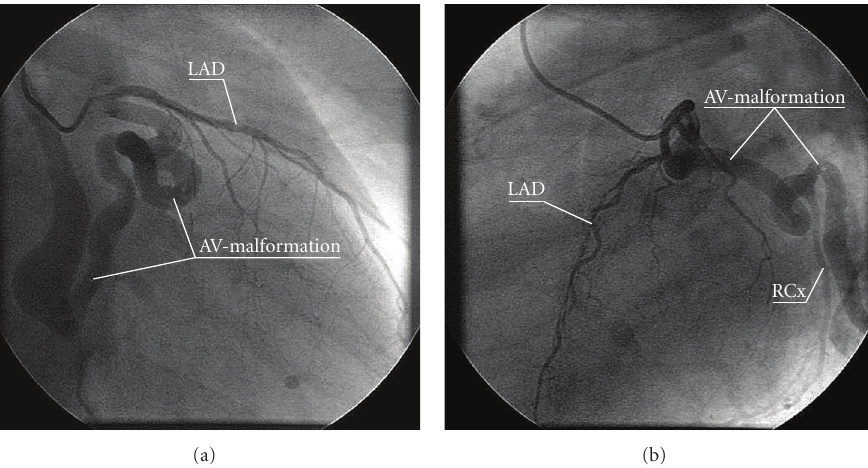
Figure 1: (a) Coronary arteriography showing a large and tortuous arteriovenous malformation originating from the left coronary sinus with a massive venous ectasia draining into the right atrium and vena cava. AV = arteriovenous. LAD = left anterior descending artery. (b) There is an aberrant circumflex artery originating from the arteriovenous malformation. AV = arteriovenous. RCx = ramus circumflex artery. LAD = left anterior descending artery.